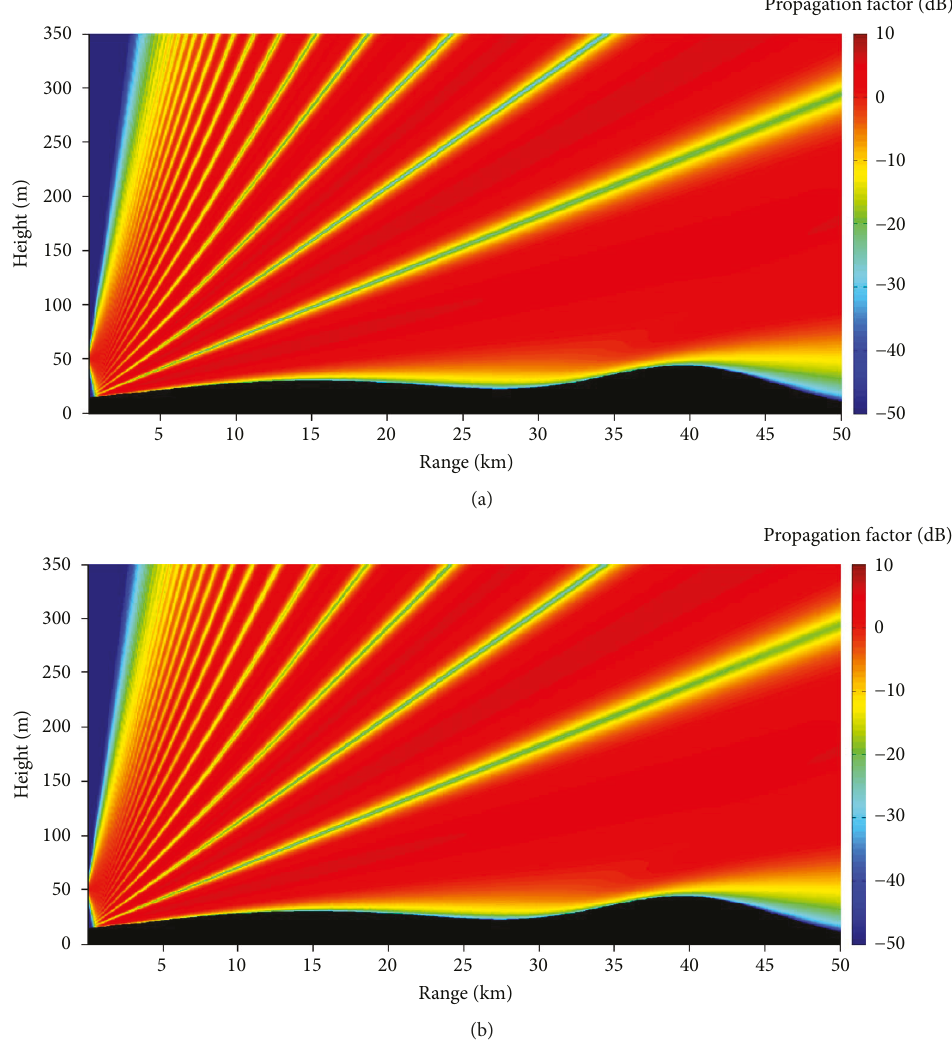
Figure 5: Propagation factor calculated by di ff erent methods: (a) the shit map; (b) the DEM-based method. Table 1: Average error and standard